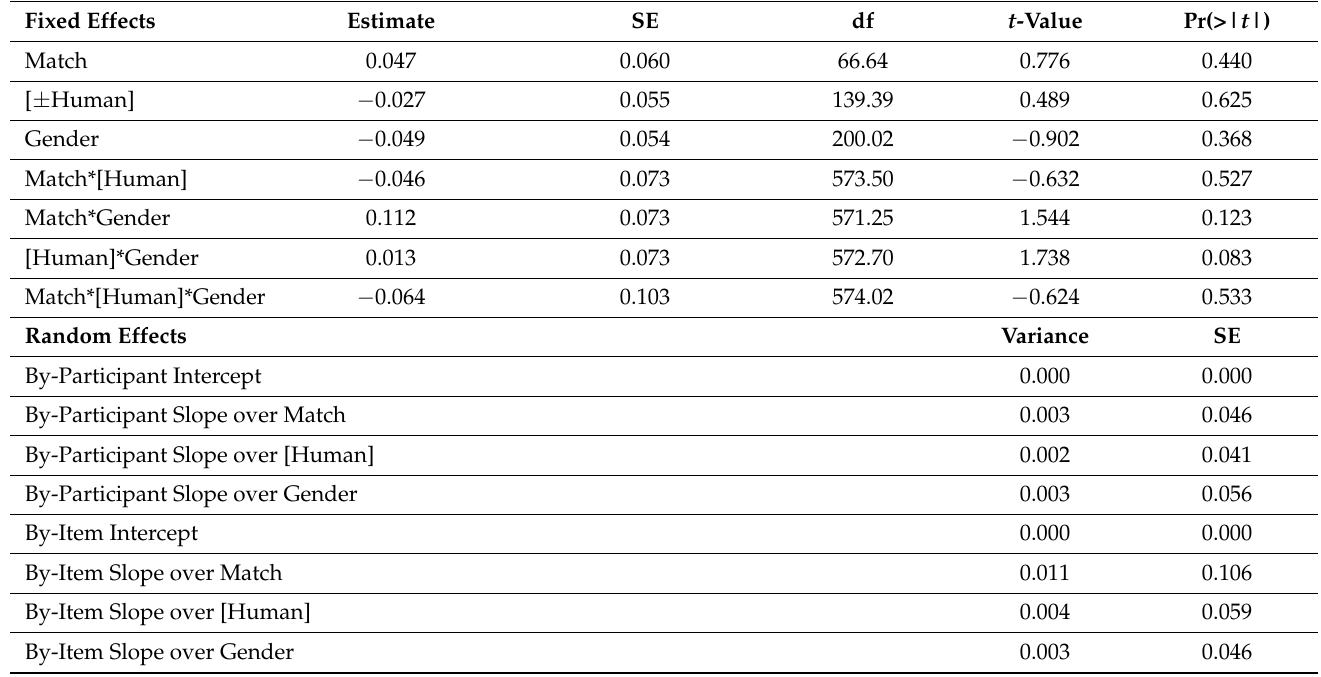
Table A2. Linear mixed-effects model, postverbal region (Region 6-SPR), L1